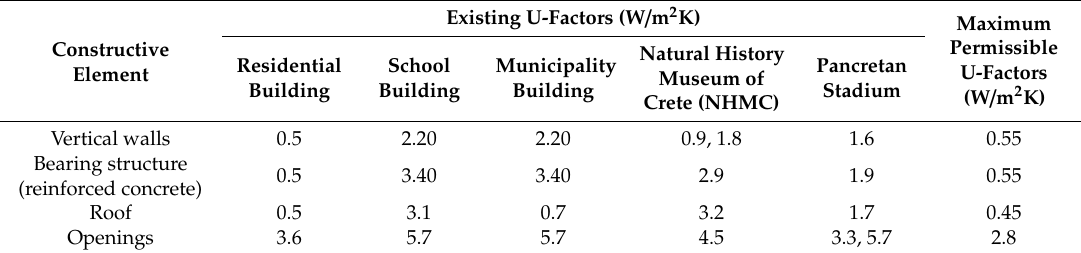
Table 1. U-factors of the examined buildings’ envelope constructive elements.